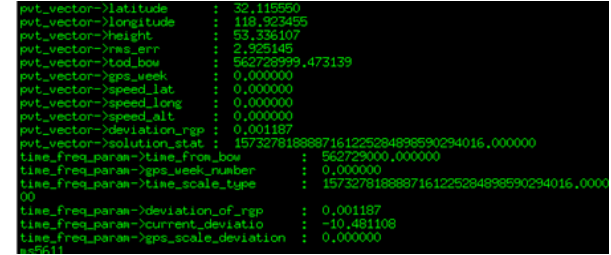
Figure 7. Partial measurement